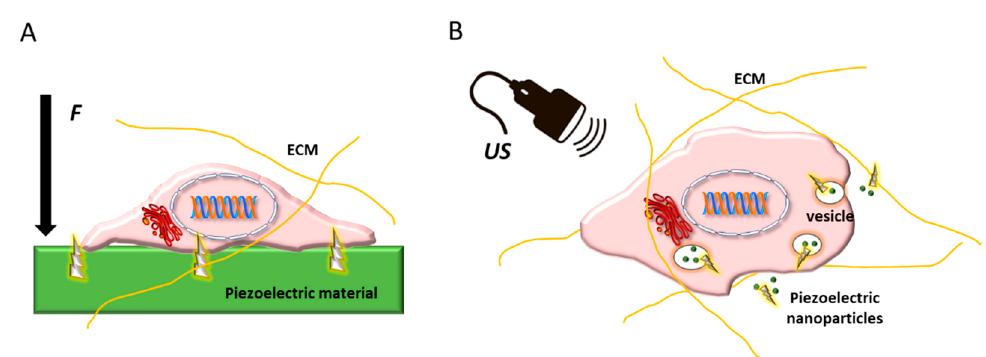
Figure 12. Schematic showing stem cell embedded in its extracellular matrix (ECM) and possible routes of using piezoelectric biomaterials to regulate its differentiation: ( A ) as substrates or scaffolds, which upon the application of an external force ( F ) give rise to electric stimuli in contact with the cell membrane; and ( B ) as nanoparticle systems trafficking intracellularly, which can be activated by ultrasound (US), thus inducing intracellular electric stimulation.